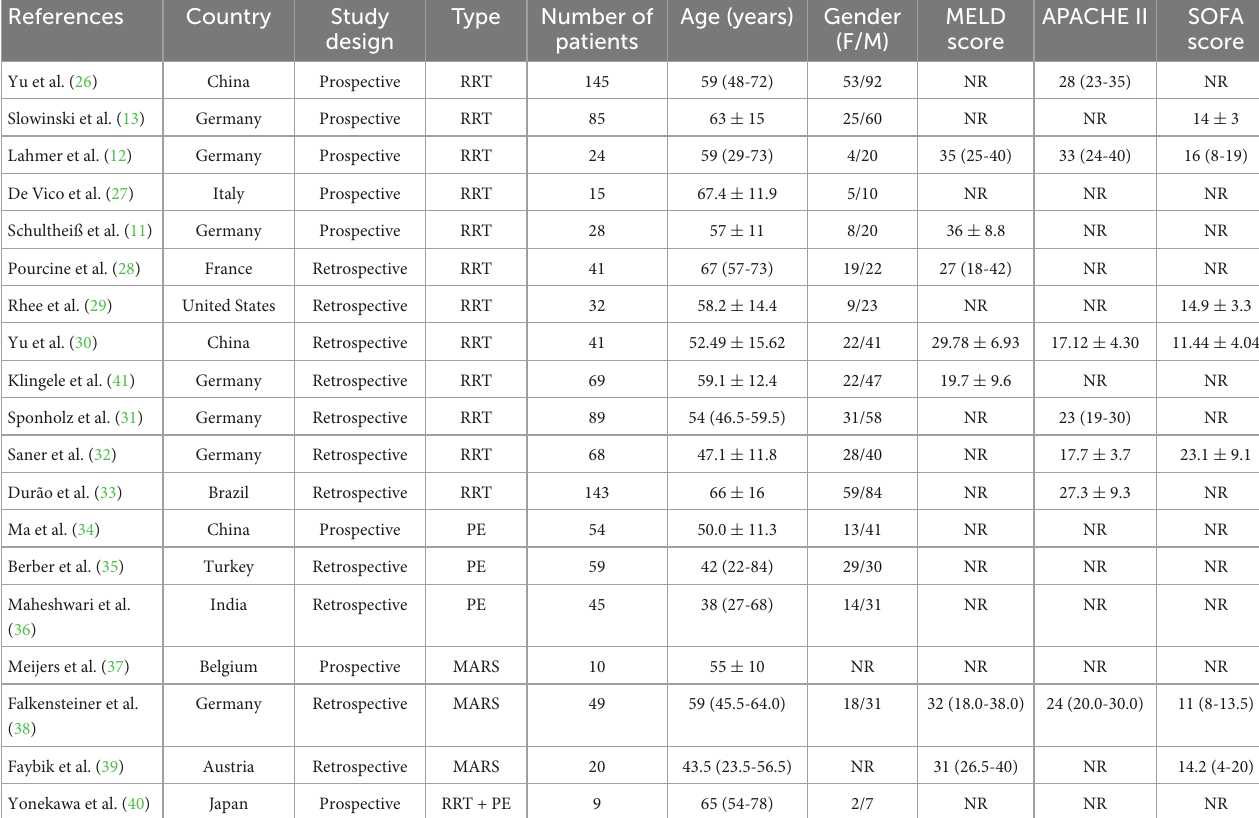
TABLE 1 Characteristics of included